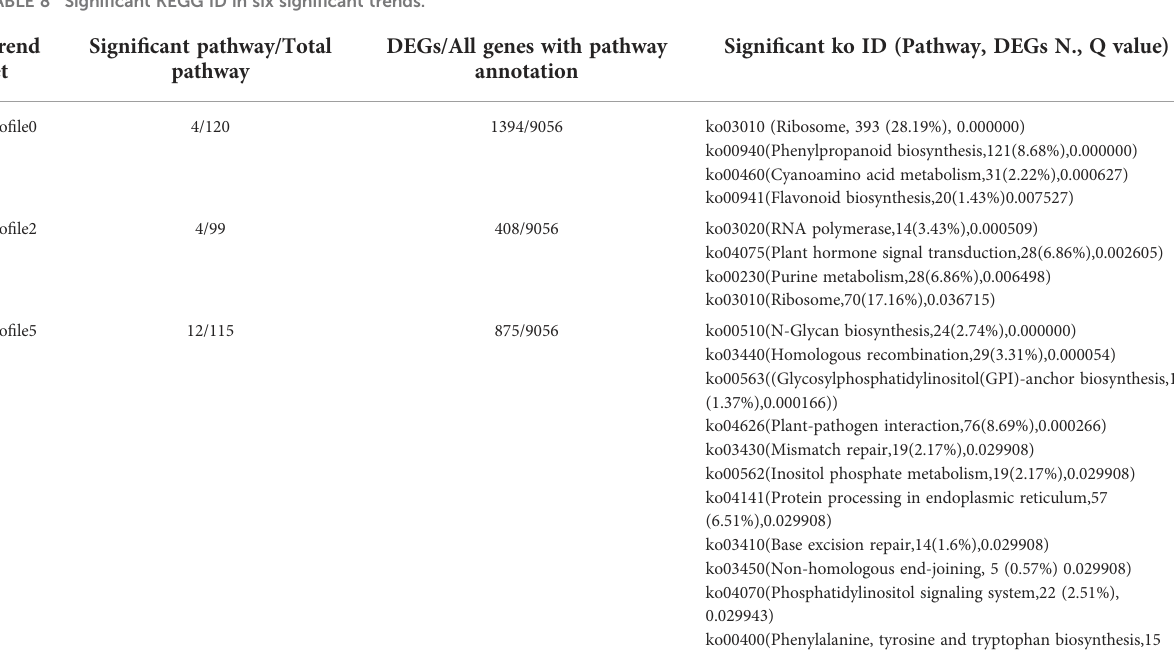
TABLE 8 Signi fi cant KEGG ID in six signi fi cant trends. Trend